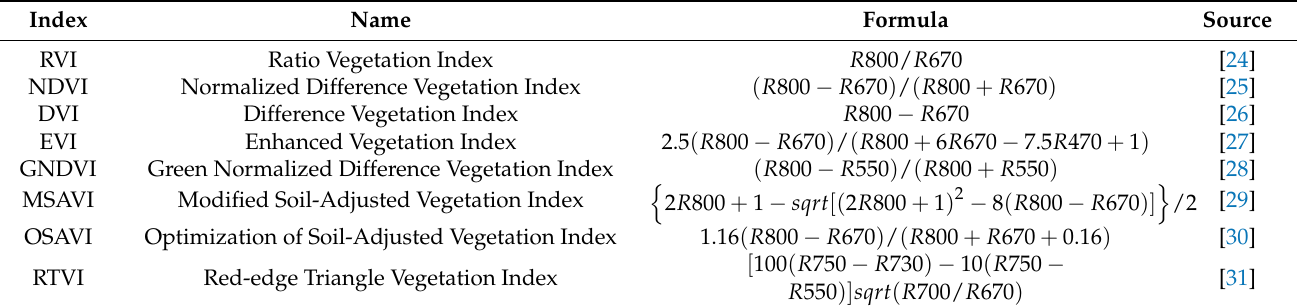
Table 1. Spectral indices used in this